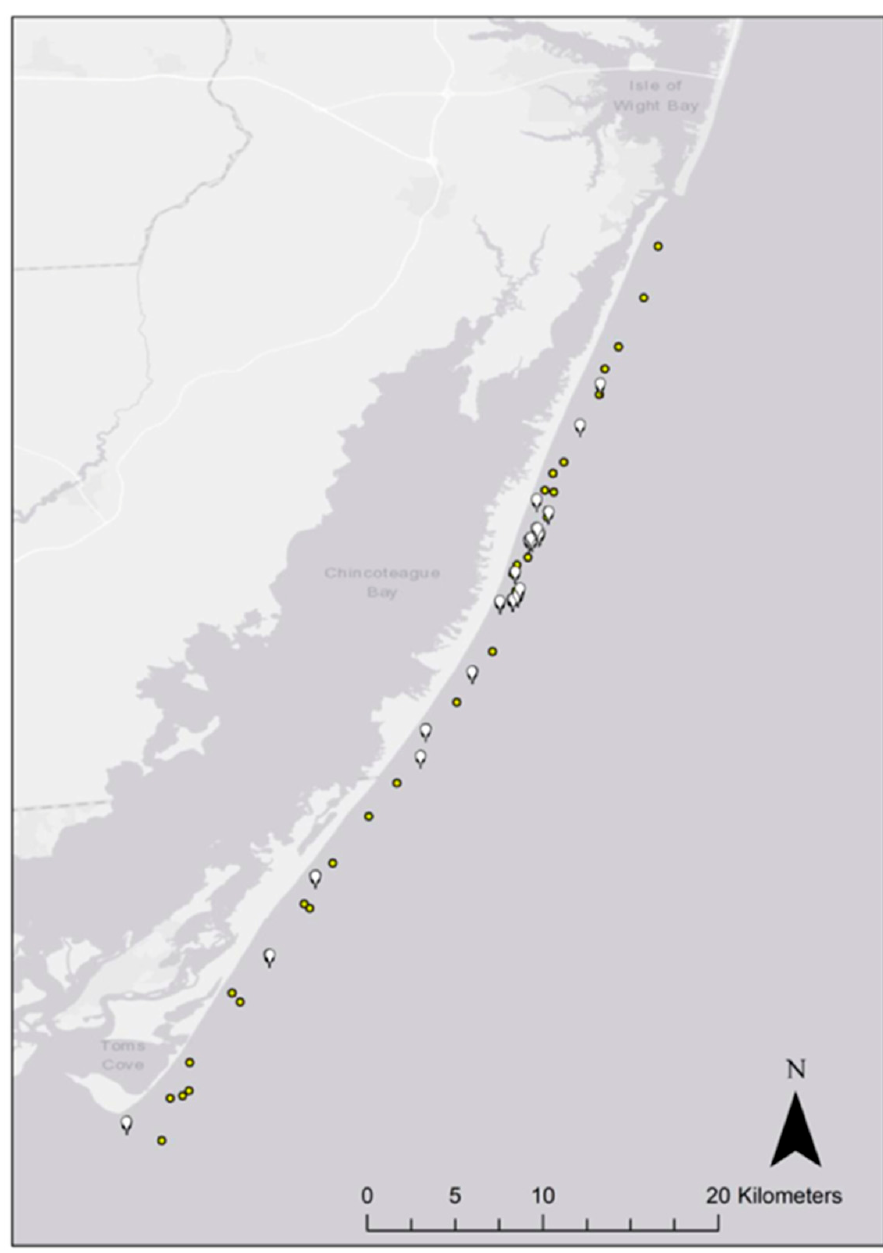
Figure 2. Post-storm (n = 120 grabs) sampled in October 2014 (n = 60 grabs, white) and 2015 (n = 60 grabs, yellow), up to 1 km offshore of Assateague Island National Seashore survey sites, Maryland.